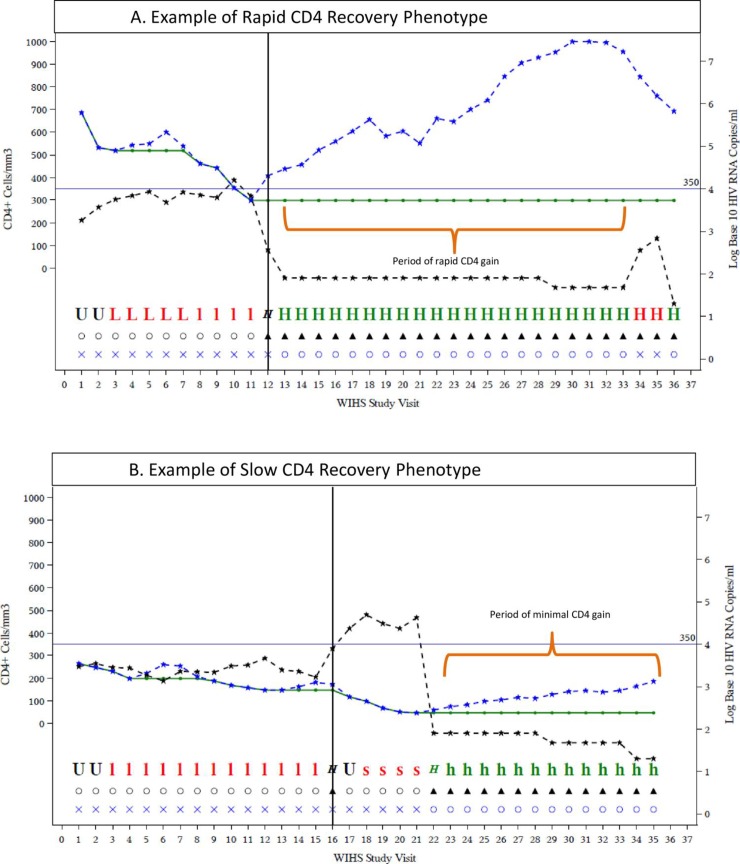
Example plots of CD4 and VL changes overtime for a good CD4 responder (1A) and a poor responder (1B). Fig 1A legend. WIHS Study Visit denotes visit number (2 visits per year). The vertical black line at visit 16 denotes the timepoint at which the beginning of the phenotypic window begins, which is followed by a period of rapid CD4 T cell gain (orange bracket). The following graphics were used to display relevant clinical, disease, and treatment information: dashed blue line denotes CD4 T cell count, solid green line denotes nadir CD4 T cell count, dashed black line denotes HIV viral load, HIV antiretroviral therapy (ART) status was denoted using ◯ (no ART) or ▲ (combination ART (cART) visit, and HIV viremia status was denoted using ◯ designated in blue font (HIV RNA below the assay detection limit) or ✖ designated in blue font (HIV RNA greater than or equal to the assay detection limit. The visit phenotype was denoted using the following symbols: U (not determined due to the lack of sufficient observation), designated in red font (long term off cART and viremic with stable CD4), l designated in green font (long term off cART and viremic with declining CD4), H (first cART visit), H designated in red font (on cART with viremia), or H designated in green font (on cART with virologic suppression). Fig 1B legend. WIHS Study Visit denotes visit number (2 visits per year). The vertical black line a visit 12 denotes the timepoint which is followed by a period of minimal CD4 T cell gain (orange bracket). The graphics were used to display relevant clinical, disease, and treatment information are the same as for Fig 1A, except that the visit phenotype had the following additional symbols: s designated in red font (short term off cART with viremia and declining CD4), H designated in green font (reinitiated cART visit), or h designated in green font (virologic suppression with minimal CD4 gain).